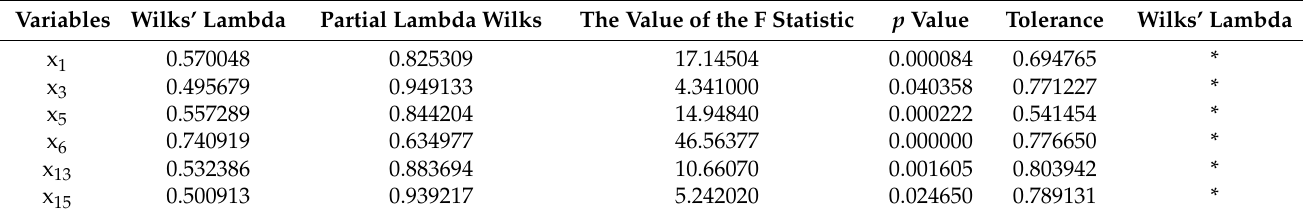
Table 7. Evaluation of the discriminant function parameters—final model (six input